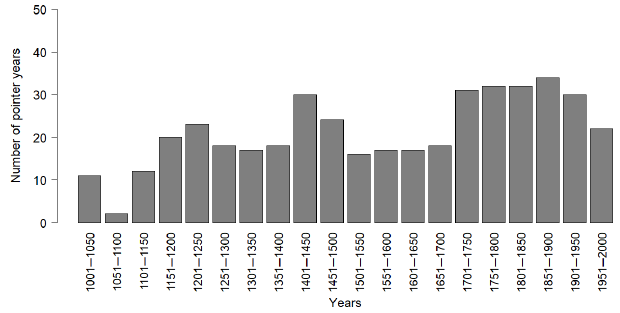
Figure 7. Number of negative pointer years (without multiple ob- servation – i.e. narrow rings in 1976 were observed on six samples but are treated as one pointer year) in Poland in 50-year periods